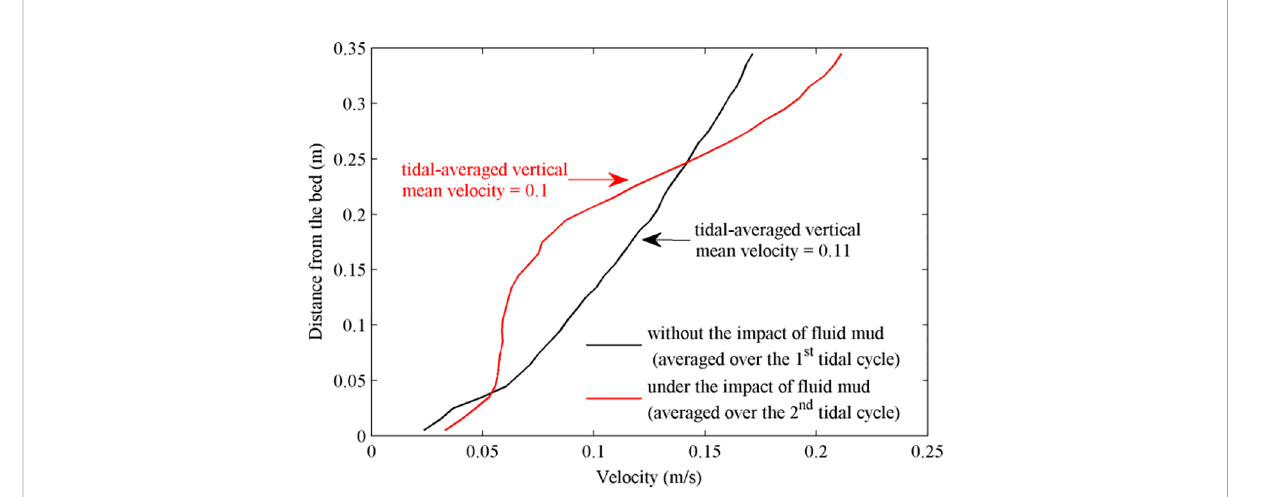
FIGURE 8 The tidal-averaged vertical pro fi le of current velocity during the Phase III of our observation